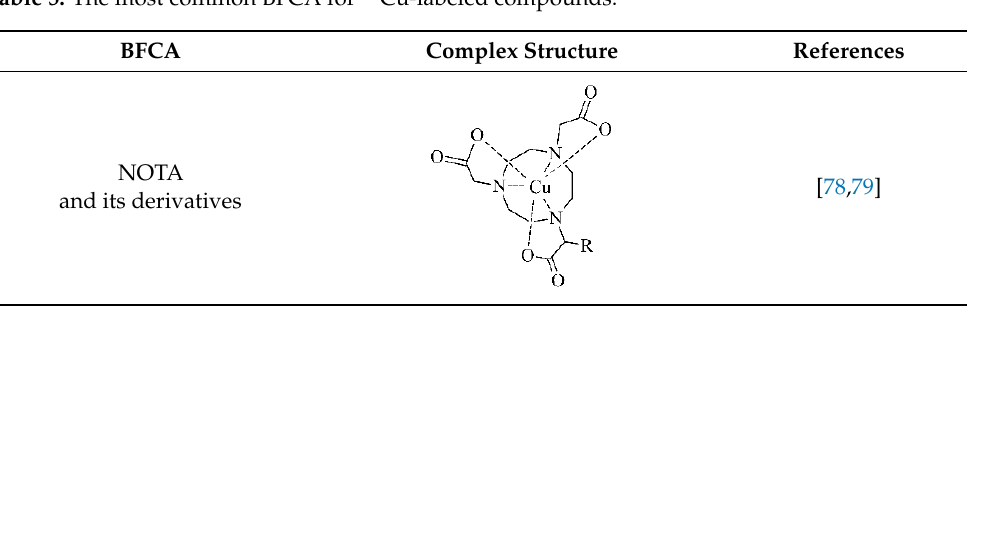
Table 5. The most common BFCA for 64 Cu-labeled compounds.